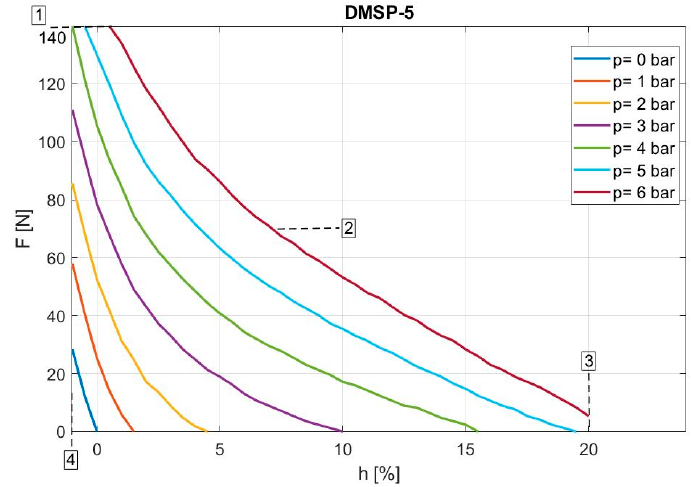
Figure 10. Operating range for the DMSP − 5 muscle [55].